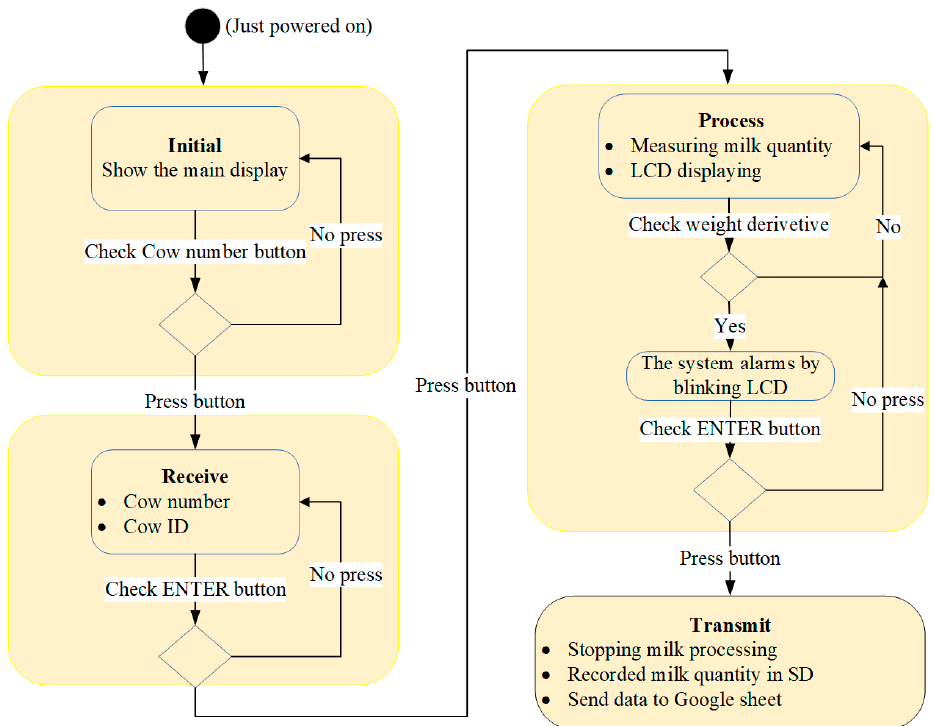
Figure 6. State transition diagram.